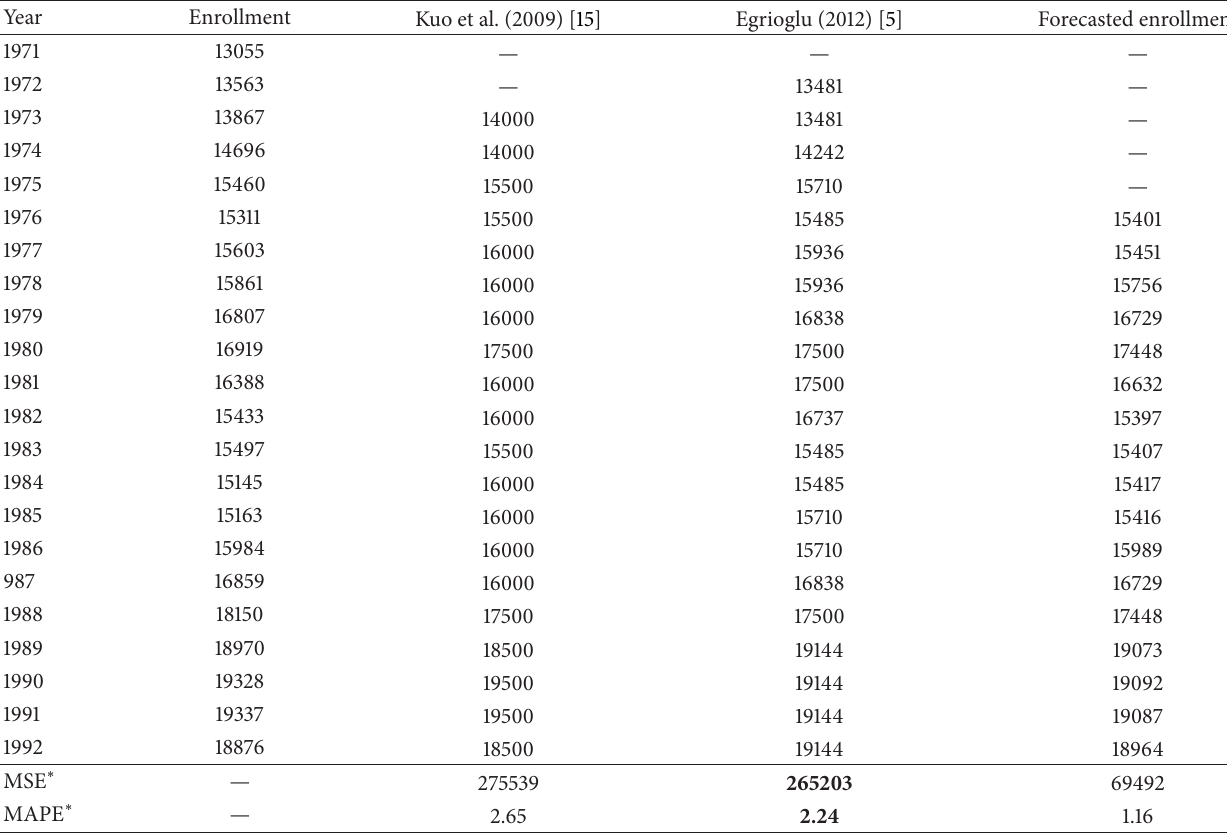
Table 3: Actual and forecasted values of the Alabama University